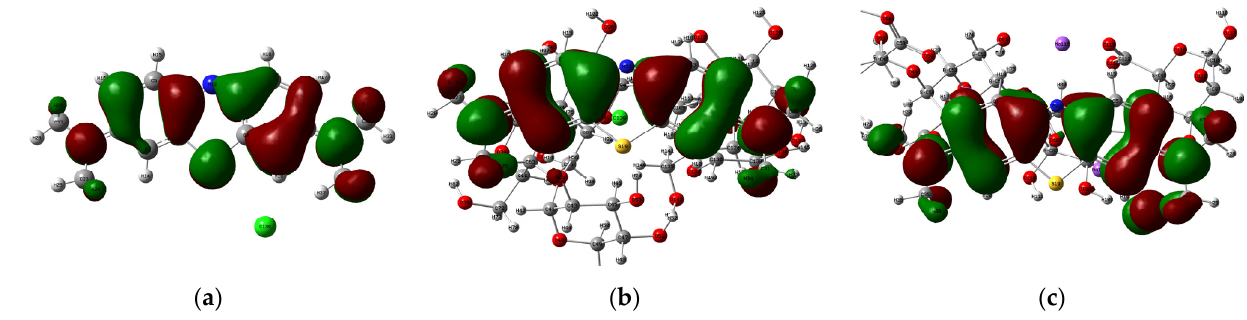
Figure 3. Shapes of molecular orbitals obtained at the B3LYP/6-31G(d) level of theory: ( a ) HOMO-3 of methylene blue (MB), ( b ) HOMO of MB/P 1, and ( c ) HOMO of MB/SA 1.